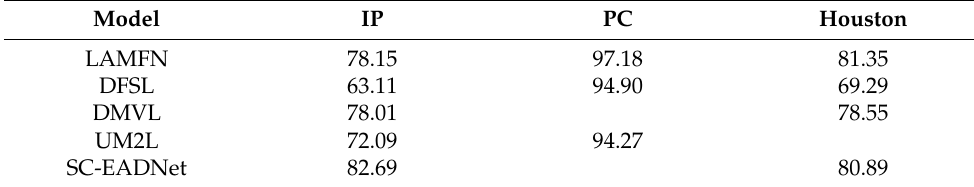
Table 11. Comparison results with several advanced semi-supervised methods.